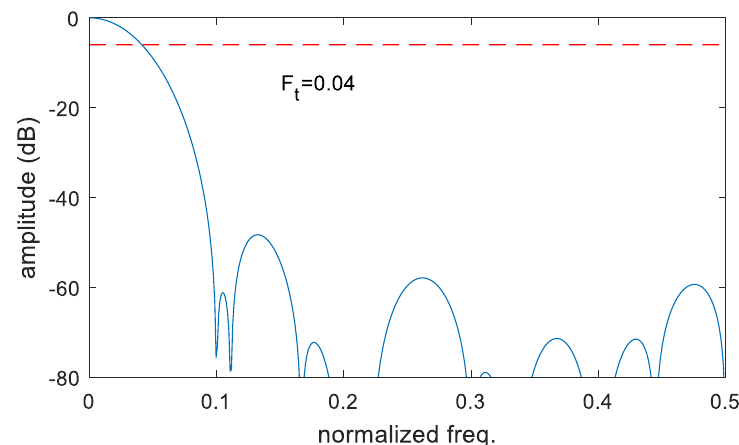
Figure 5. Filter mask obtained by the CIC architecture of Figure 6 with K 0 = 9, K 1 = 5, K 2 = 10, K 3 = 3, D 1 = 1, D 2 = 1, D 3 = 2, D 4 = 1. The cut-off normalized frequency is F L = 0.04. Horizontal dashed line represents the –6 dB level.